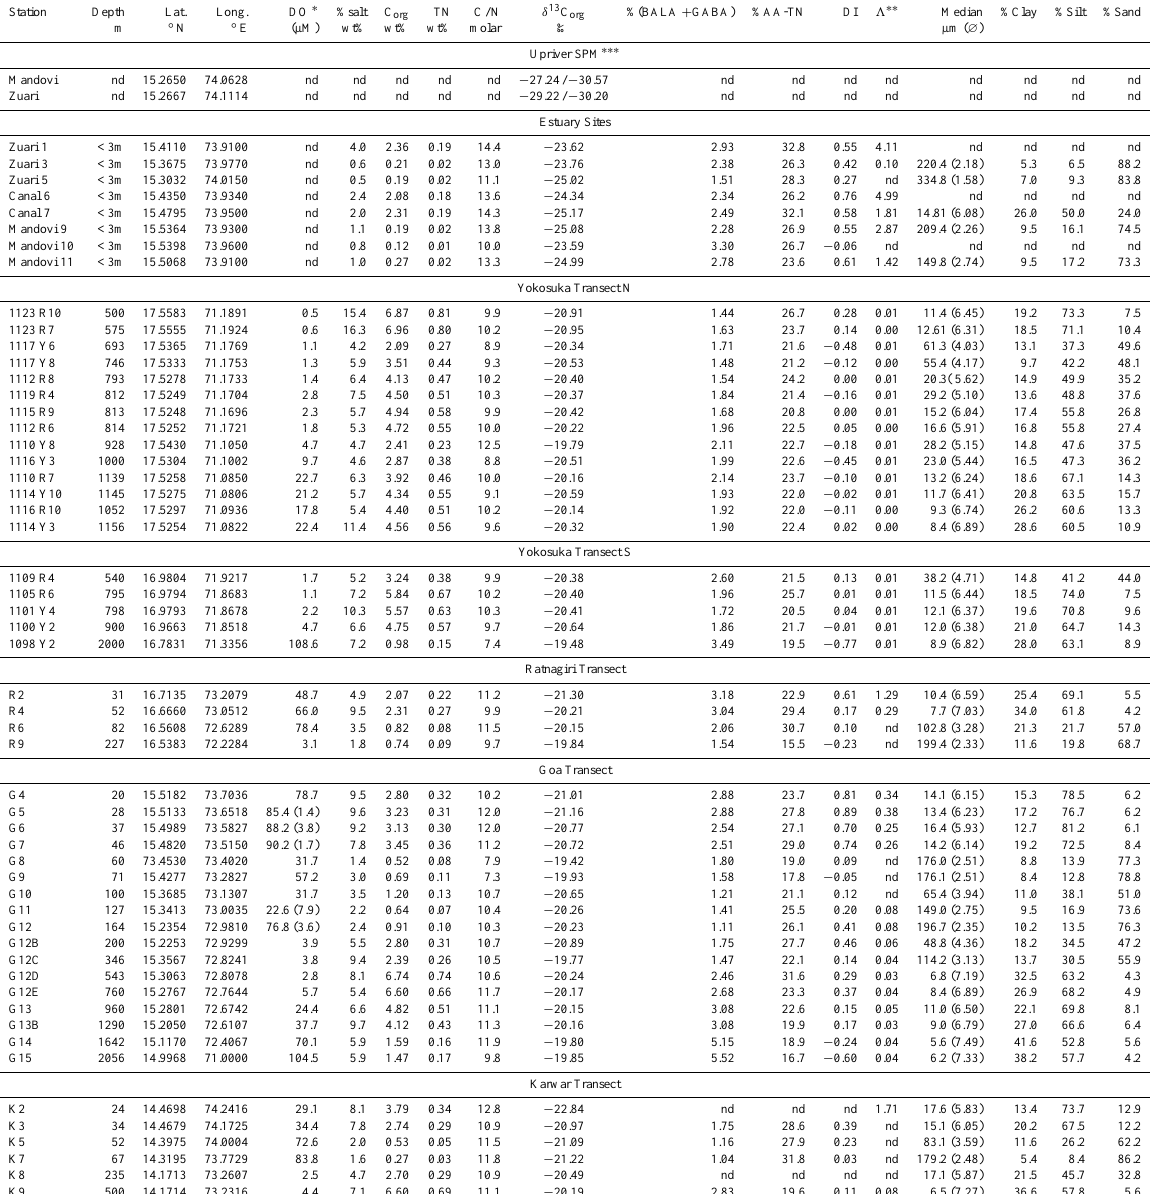
Site and sample compositional data. ∗ DO values as recorded at time of sampling, intermonsoon (late monsoon); ∗∗ (cid:51) = total lignin phenol yields in mg100mg − 1 C org ; ∗∗∗ riverine suspended particulate material (SPM) collected in intermonsoon / late monsoon seasons. Median = median grain size; Clay, silt and sand are percentages by volume. Other parameters are as defined in the